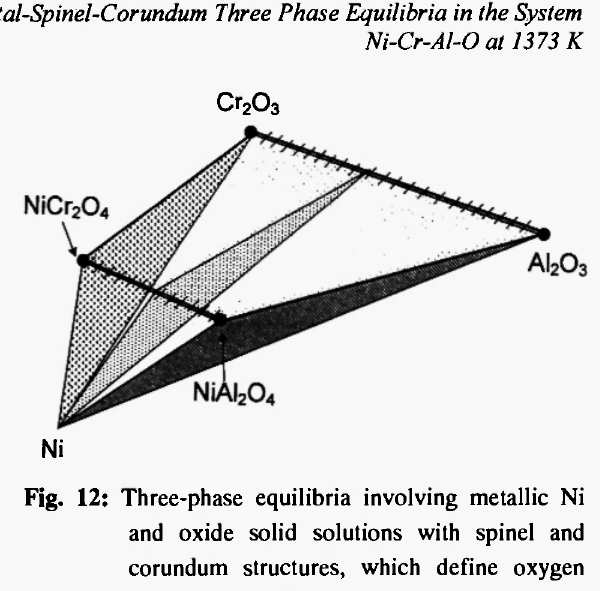
Fig. 12: Three-phase equilibria involving metallic Ni and oxide solid solutions with spinel and corundum structures, which define oxygen potentials at constant temperature.